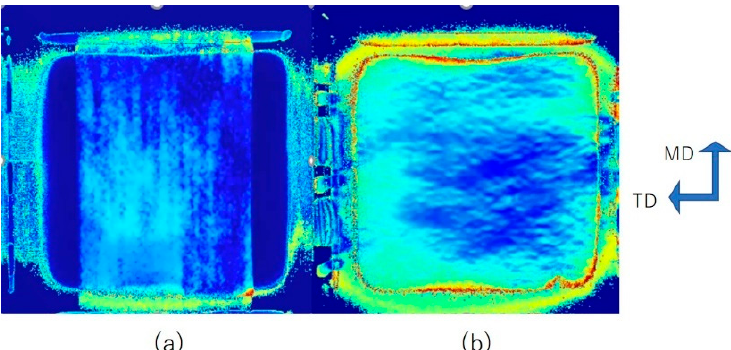
Figure 3. Retardation image of uniaxial: ( a ) free-width ( b ) constrained-width stretching along the MD at DR = 4 with stretching speed of 1 m/min.